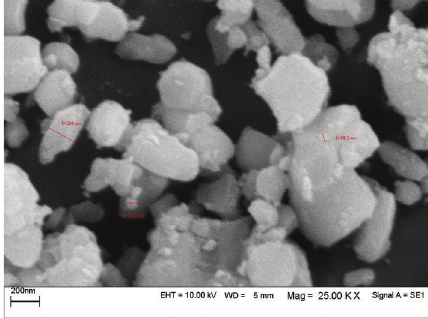
Figure 3: SEM of synthesized HAp and particle